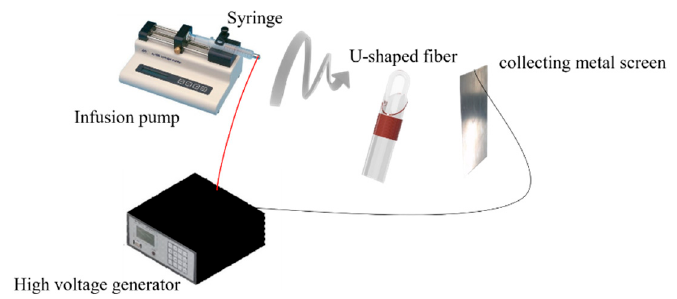
Figure 2. Schematic of electrospinning the PVA layer onto the sensor.